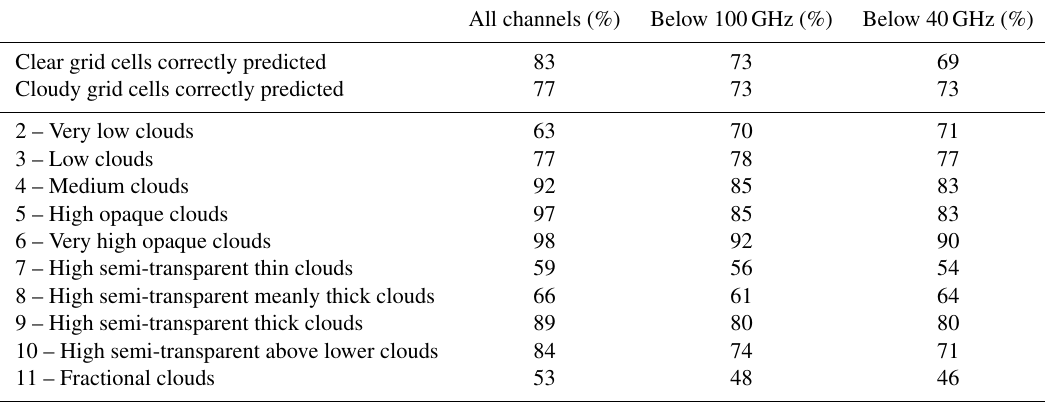
Table 5. Classification results for the different clear and cloudy populations for the three MW frequency ranges. See text for more details. All channels (%) Below 100GHz (%) Below 40GHz (%) Clear cells correctly predicted 88 77 71 MW cloud-contaminated cells correctly predicted 84 76 78 Ambiguous grid cells predicted as MW cloud contaminated 49 43 52